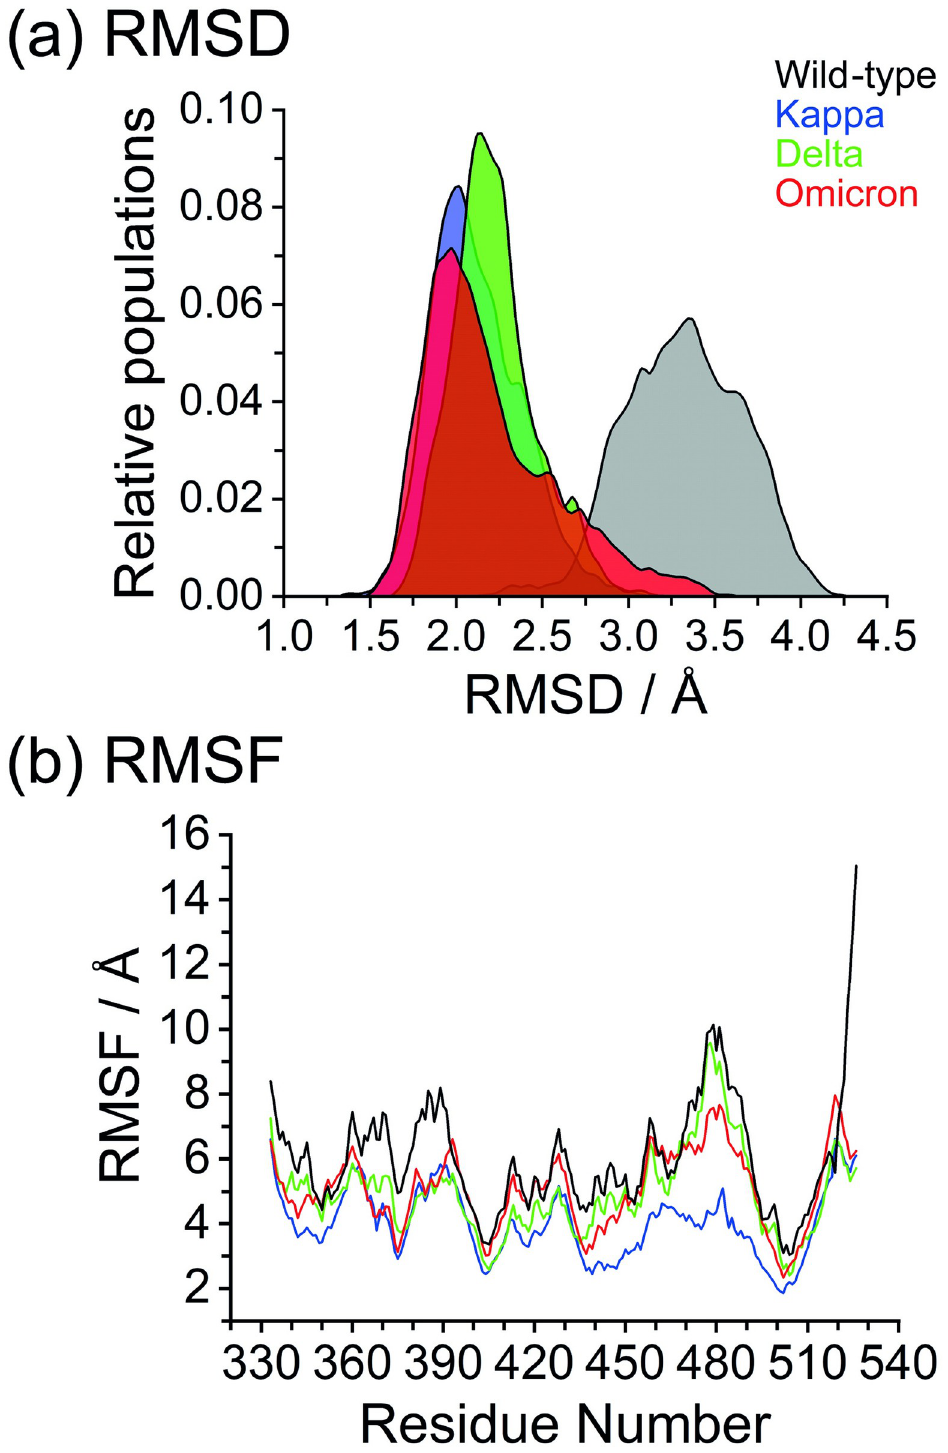
Fig 4. The molecular dynamics results of the ACE2-bound S-RBD complex with the wild-type, Kappa, Delta, and Omicron variants over 50 ns simulation times. (a) RMSD distribution, and (b) RMSF of C α -atom of spike RBD; wild-type, Kappa, Delta, and Omicron, in complex with the ACE2. The positions of spike RBD-ACE2 binding region are denoted the fragment of residues 438–505.